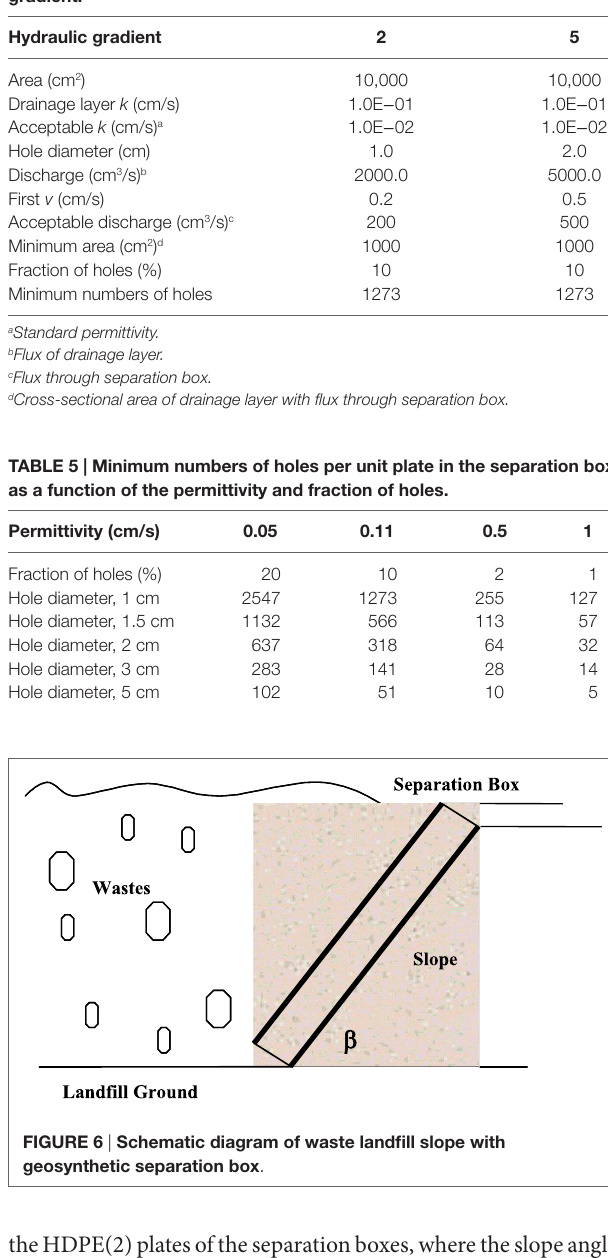
TaBle 4 | Minimum number and area of holes in the unit plate in the separation box as a function of the diameter of the holes and hydraulic gradient.